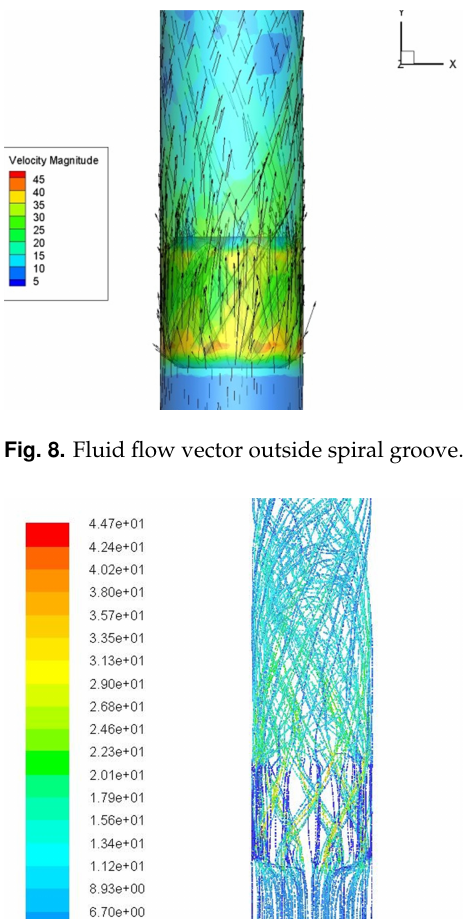
Fig. 11. Tangential injection velocity vector